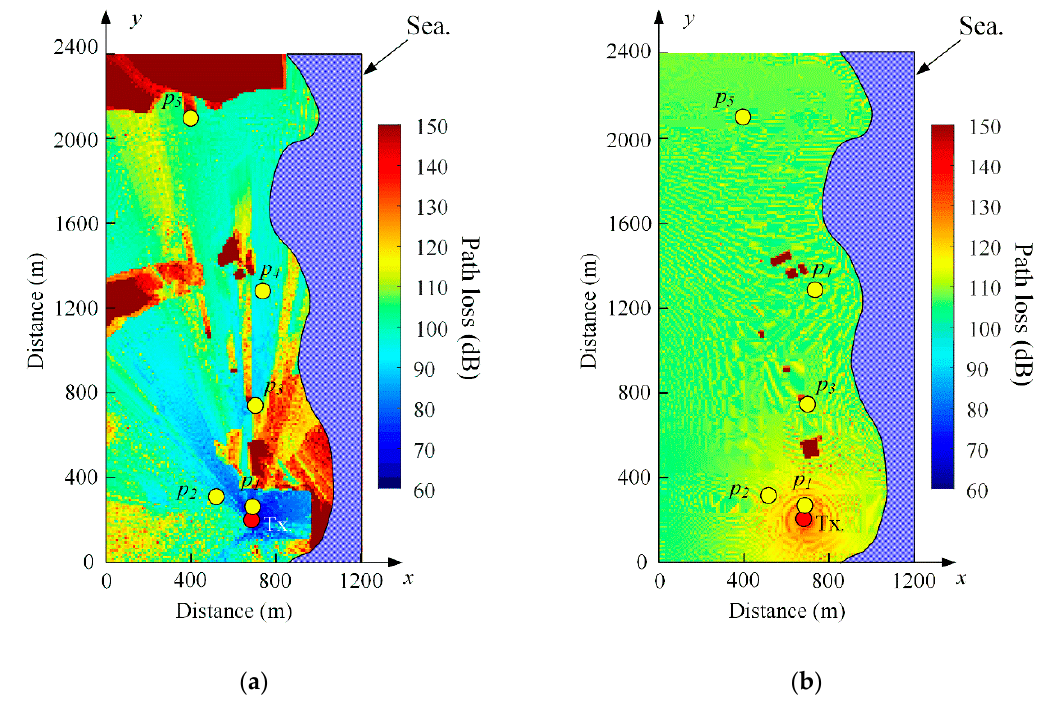
Figure 4. Path loss distributions according to rocket altitude: ( a ) at 0 m; ( b ) at 1000 m.